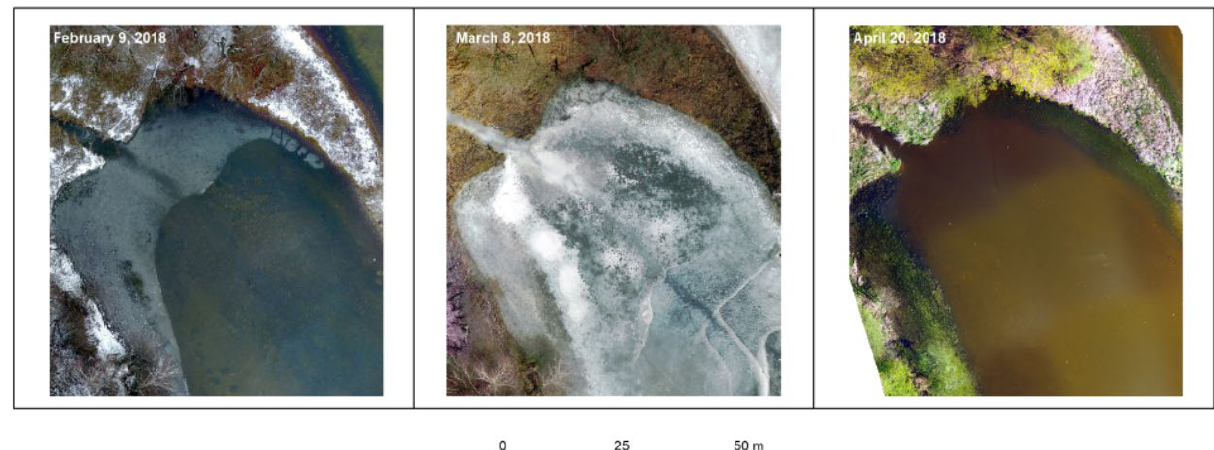
Figure 2. The appearance of the area of interest in the monitored period: February 9, 2018; March 8, 2018;